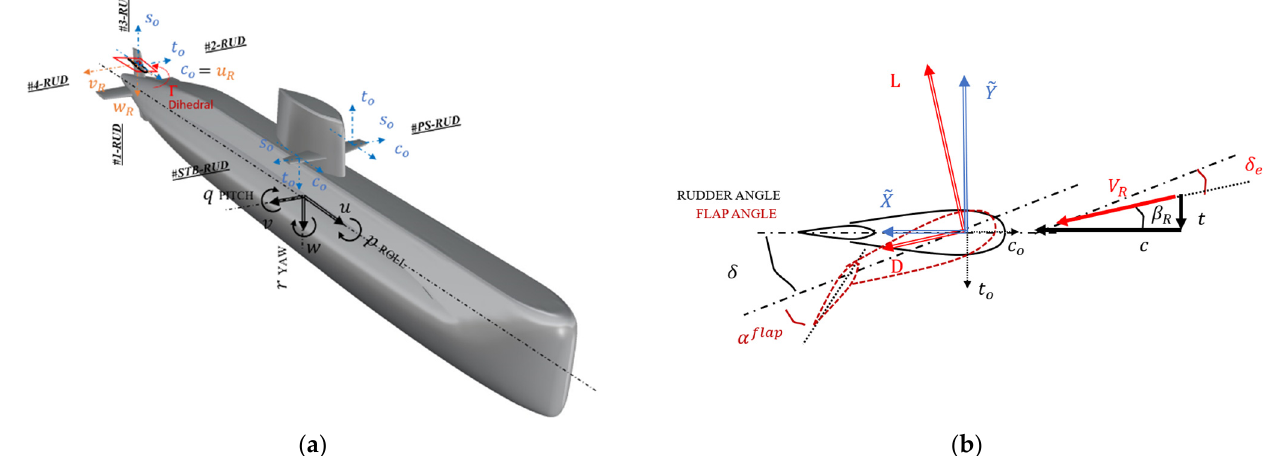
Figure 1. Reference systems. ( a ) Vehicle kinematics. ( b ) Control planes definitions.